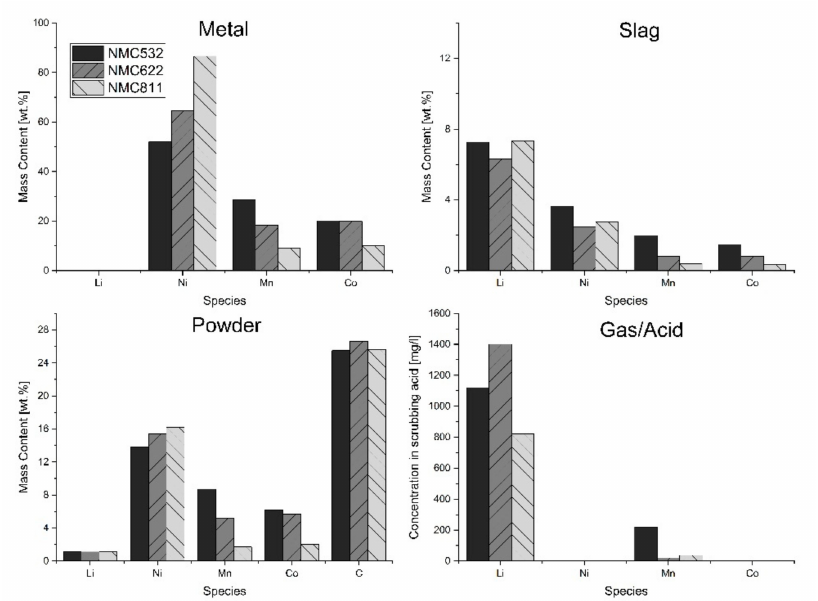
Figure 8. Overview on the analysis results for Ni, Mn, Co, and Li in the obtained product phases (metal, slag, powder, and gas) of the InduMelt experimental